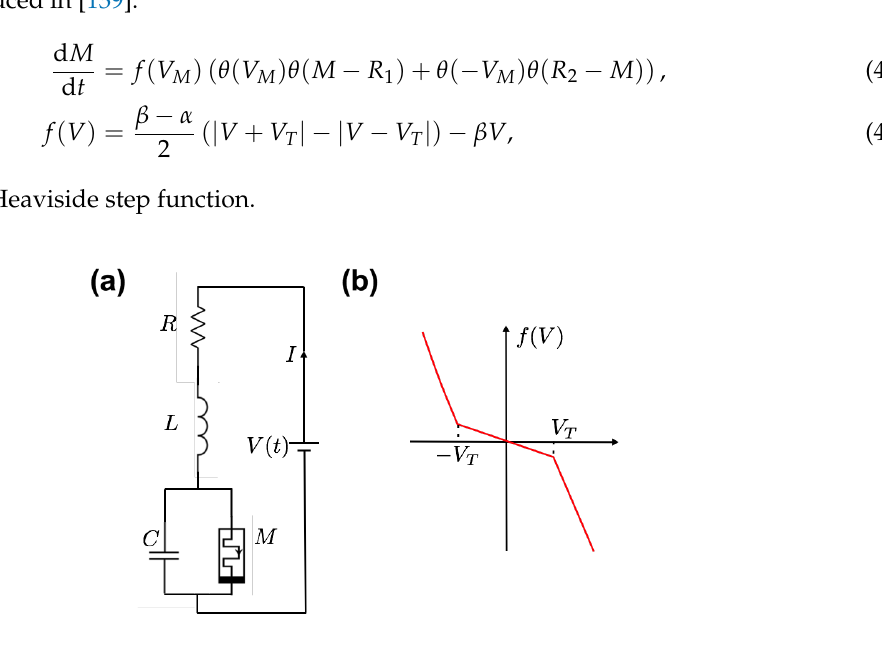
Figure 11. The amoeba memristive learning model of [138]. ( a ) the circuit with capacitance C and memristor M in parallel (with resistance R ( t ) ), and in series to a resistance R and an inductance L ; ( b ) the function f ( V ) for the memristor response in